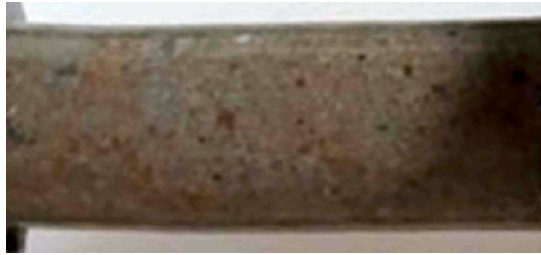
Figure 10. Wash contact time of 10 min.